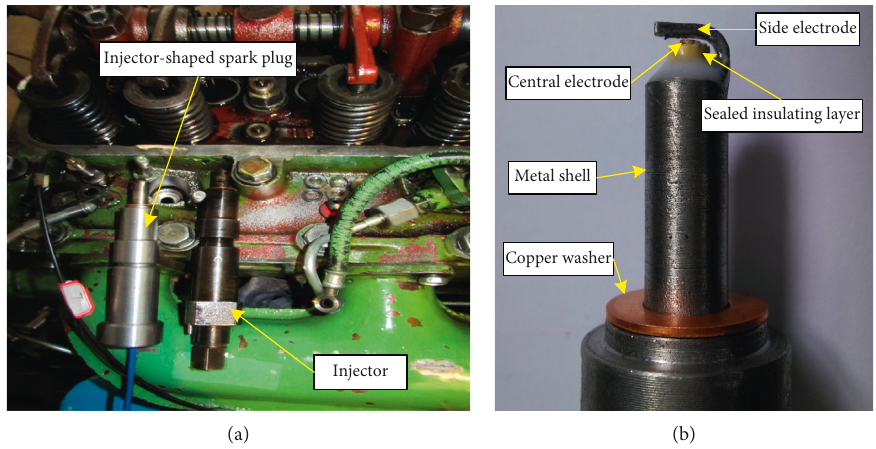
Figure 4: The injector-shaped spark plug. (a) Physical diagram. (b) Spark plug head.